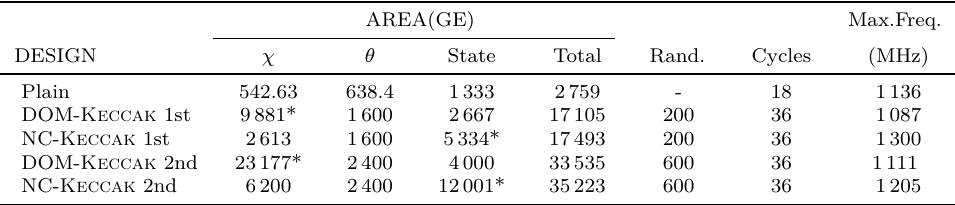
Table 1: Synthesis results for the different designs